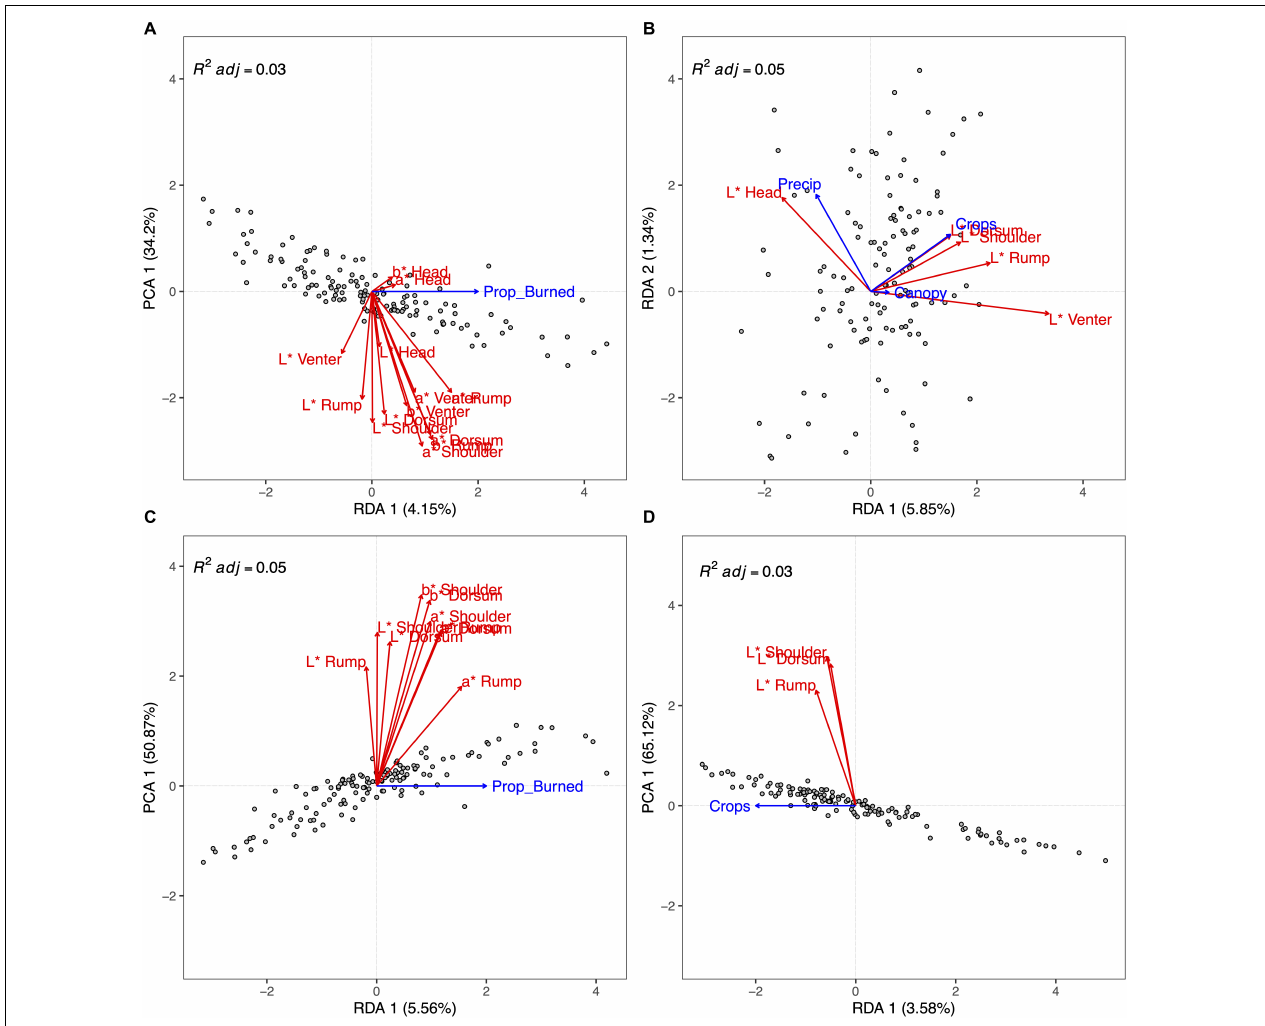
FIGURE 5 | Results of forward selection redundancy analysis (RDA) showing associations between ecological factors and eastern fox squirrel pelage color measurements at multiple locations on each specimen. Each plot shows a different, non-exclusive data subset ( (A) = full specimen [head, shoulder, dorsum, rump, venter]), full color [L*, a*, b*]; (B) = Full specimen, brightness only [L*]; (C) = dorsal [shoulder, dorsum, rump], full color; (D) = dorsal, brightness only). The length of each environmental variable (blue arrow) along each axis correlates to the amount of variation that variable accounts for. Pelage measurements (red arrows) positively correlate with an environmental variable if both arrows stretch in the same direction. For plots (A) , (C) , and (D) , the x -axis shows the only significant RDA axis from forward selection, while the y-axis shows the first principal components (PCA). The PCA axis represents the residuals of the constrained